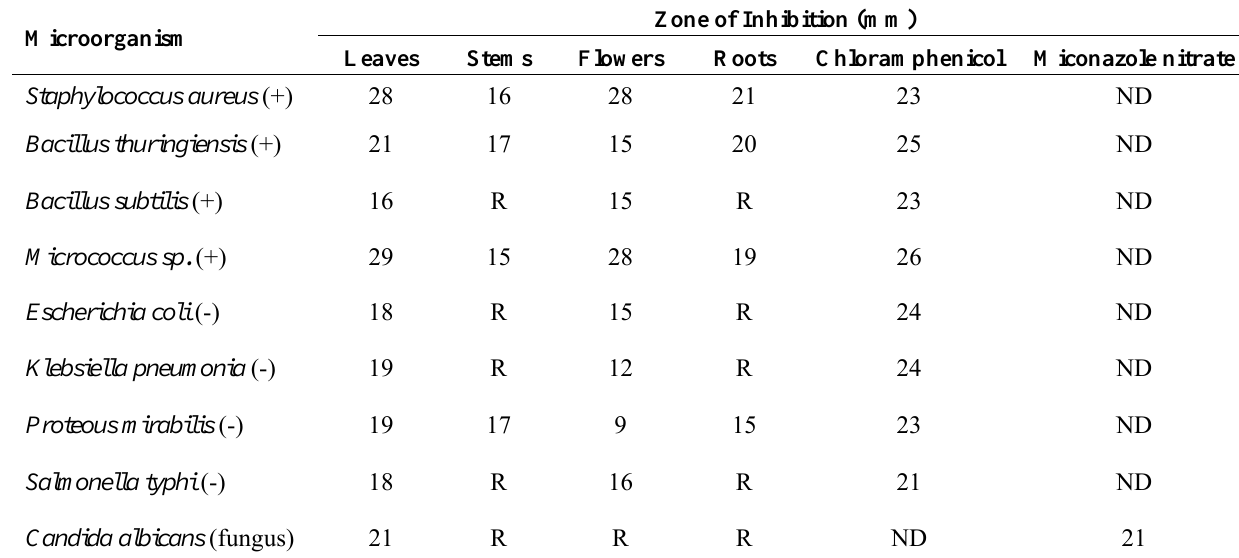
Table 1. Antimicrobial activity of Euphorbia hirta expressed as zone of inhibition (mm). Zone of Inhibition (mm) Microorganism Leaves Stems Flowers Roots Chloramphenicol Miconazole nitrate Staphylococcus aureus (+) 28 16 28 21 23 ND Bacillus thuringiensis (+) 21 17 15 20 25 ND Bacillus subtilis (+) 16 R 15 R 23 ND Micrococcus sp. (+) 29 15 28 19 26 ND Escherichia coli (-) 18 R 15 R 24 ND Klebsiella pneumonia (-) 19 R 12 R 24 ND Proteous mirabilis (-) 19 17 9 15 23 ND Salmonella typhi (-) 18 R 16 R 21 ND Candida albicans (fungus) 21 R R R ND